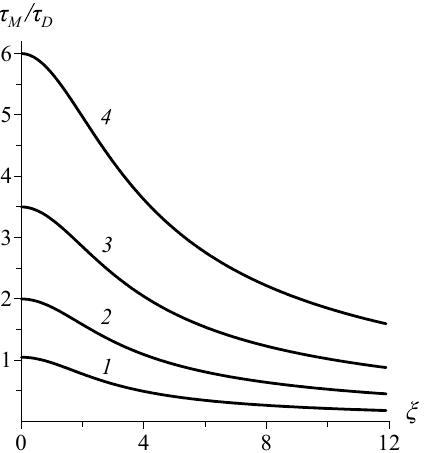
Figure 3. Dependence of the integral relaxation time on the strength of bias field for MRX in “transverse” configuration; the viscoelasticity parameter κ = 2 × 10 3 ( 1 ), 100 ( 2 ), 40 ( 3 ), 20 ( 4 ); “maxwellity” of the corona is q =